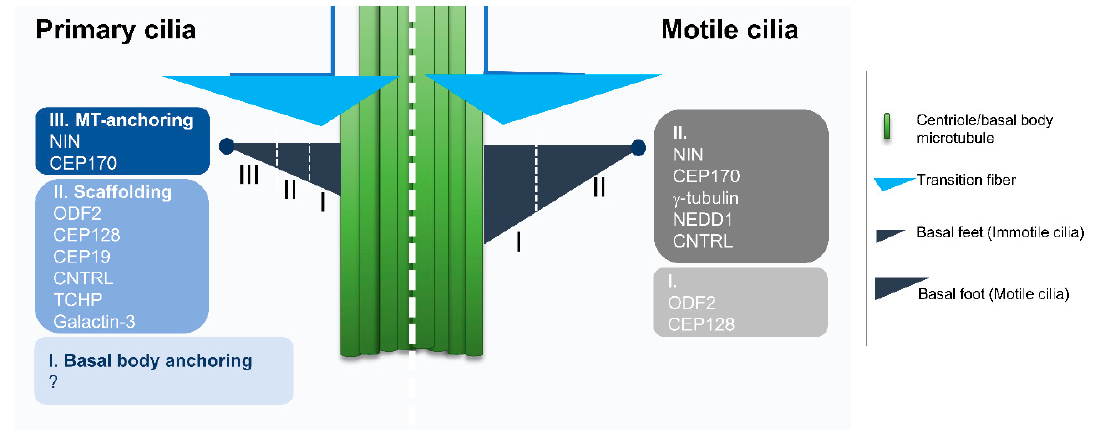
Figure 2. Comparison of the Structural Organization and major components of basal feet from primary and motile cilia. Primary and motile cilia basal feet present different components and domain organizations as observed by super-resolution microscopy. Primary cilia have multiple basal feet whose components are organized in three distinct domains. The most distal region (III) is characterized by the presence of Ninein (NIN) and Centrosomal protein of 170 kDa (CEP170), proteins involved in microtubule (MT) anchoring and components of the centriole sub-distal appendages. The next region (II) contains proteins that are possibly involved in the scaffolding of the basal feet, namely Outer dense fiber protein 2 (ODF2). The most proximal region (I) to the basal body was named “basal body anchoring” although there was no protein assigned to this region. Motile cilia present only one basal foot, aligned with the cilia beating direction. The domain organization is simpler than that of primary cilia, corresponding, to a certain extent to a rearrangement of Regions II and III. On the most distal region of the basal foot (II), besides the proteins in common with the basal feet of primary cilia (i.e. NIN, CEP170, Centriolin (CNTRL)), there are proteins of the γ -tubulin ring complex ( γ -TURC) microtubule nucleating complex (i.e. γ -tubulin and protein NEDD1). The most proximal region (I) contains proteins that are common to the primary cilia basal feet (i.e. Centrosomal protein of 128 kDa (CEP128) and ODF2) that are most likely responsible for the scaffolding (based on proteomics and super-resolution microscopy data in [53]).